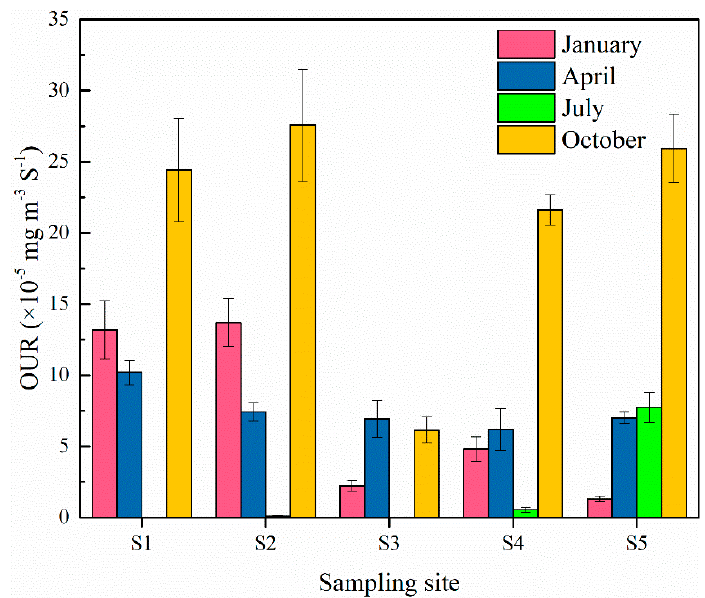
Figure 3. Oxygen uptake rate (OUR) of the sediment during the field investigation period. Error bars indicate the standard deviation, n=3.